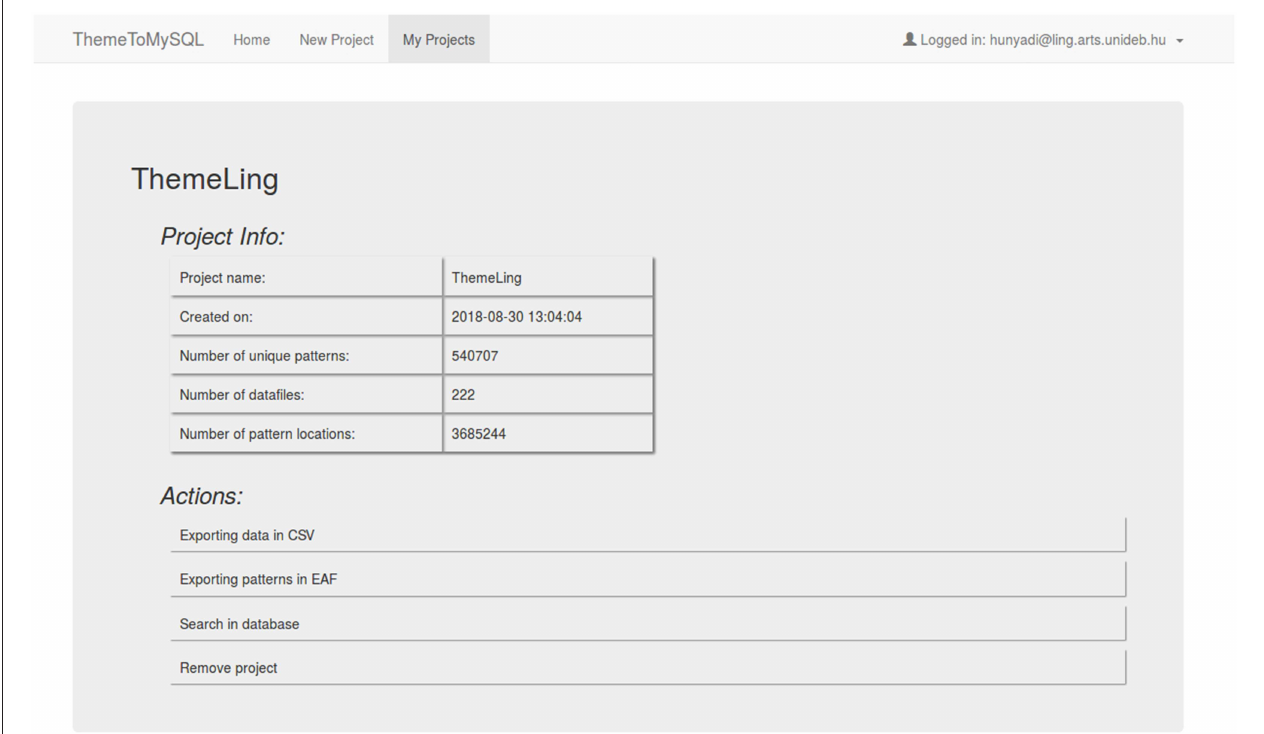
FIGURE 7 | Overview of an imported Theme project: general statistics and management possibilities.